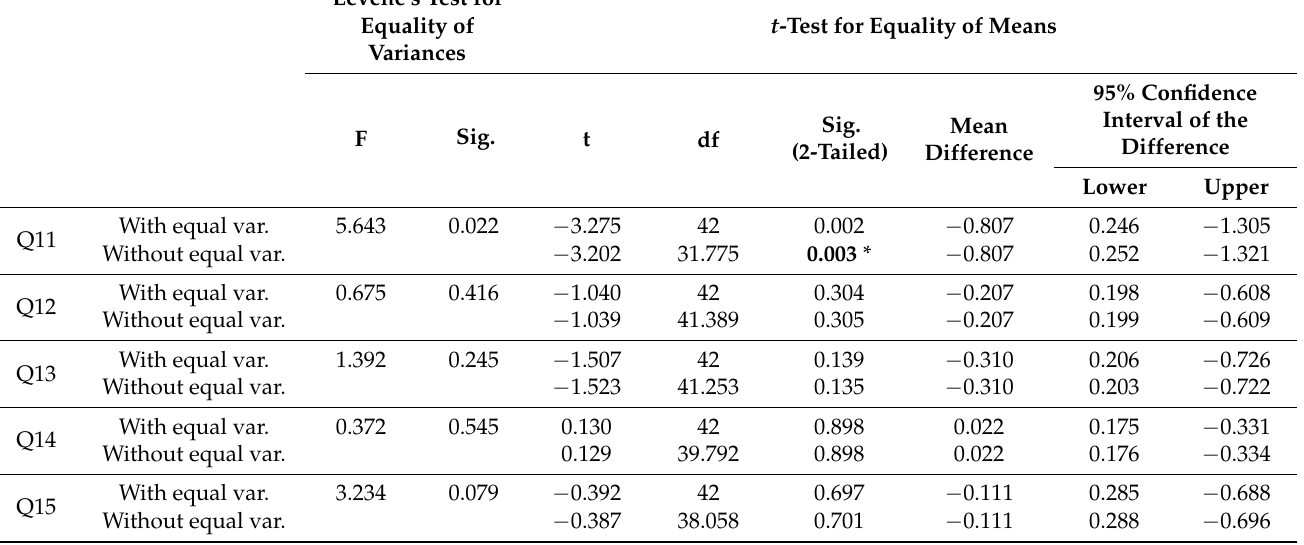
Table 8. Students’ attitudes toward motivation